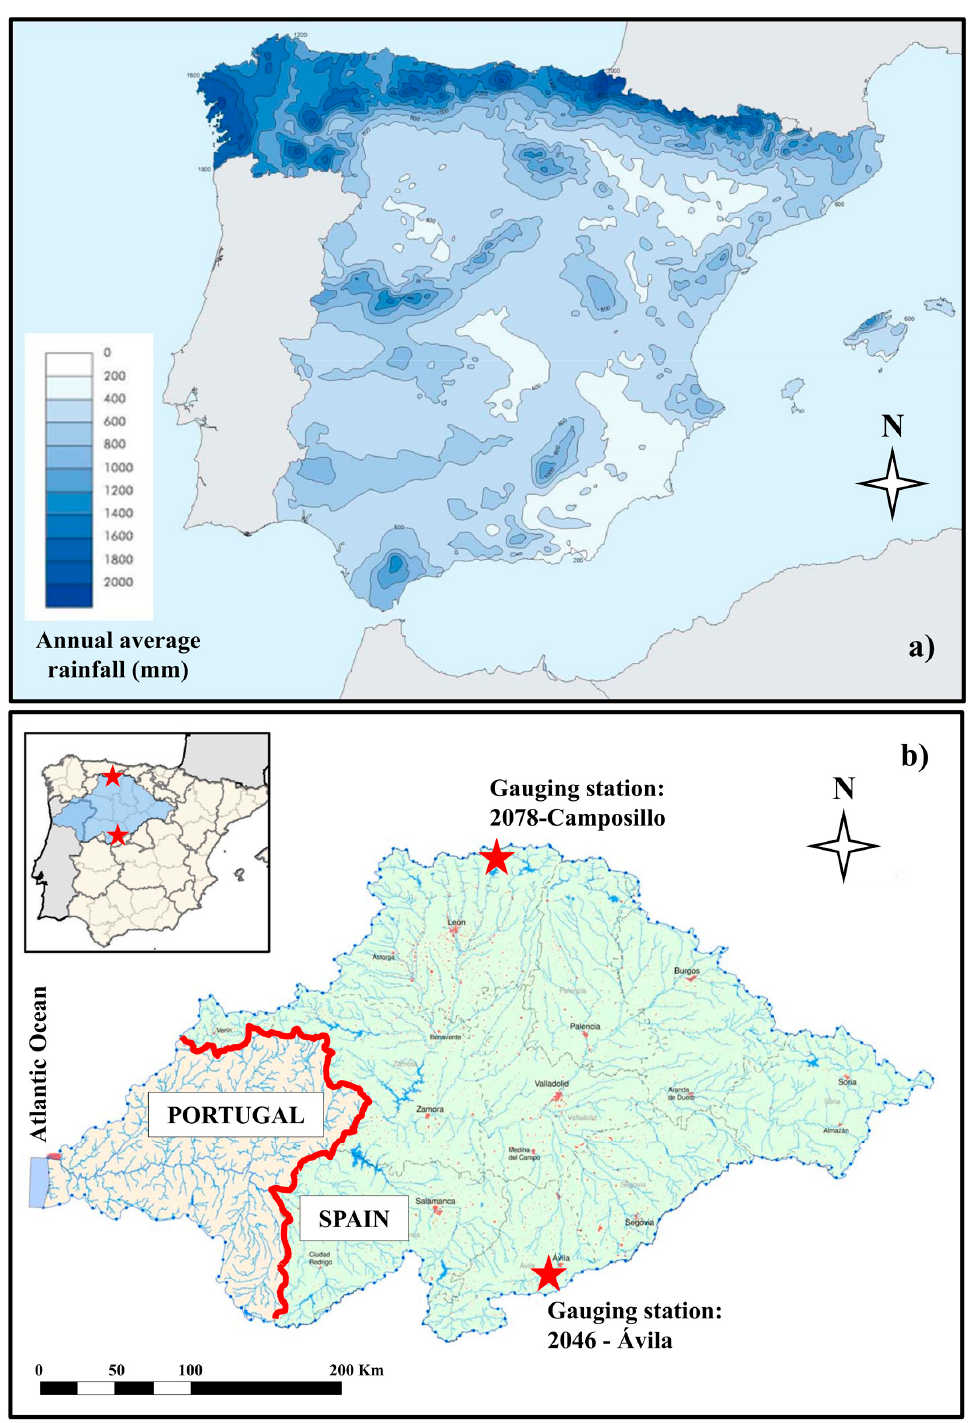
Figure 1. ( a ) Annual average rainfall distribution in Spain; ( b ) Duero river basin and location of